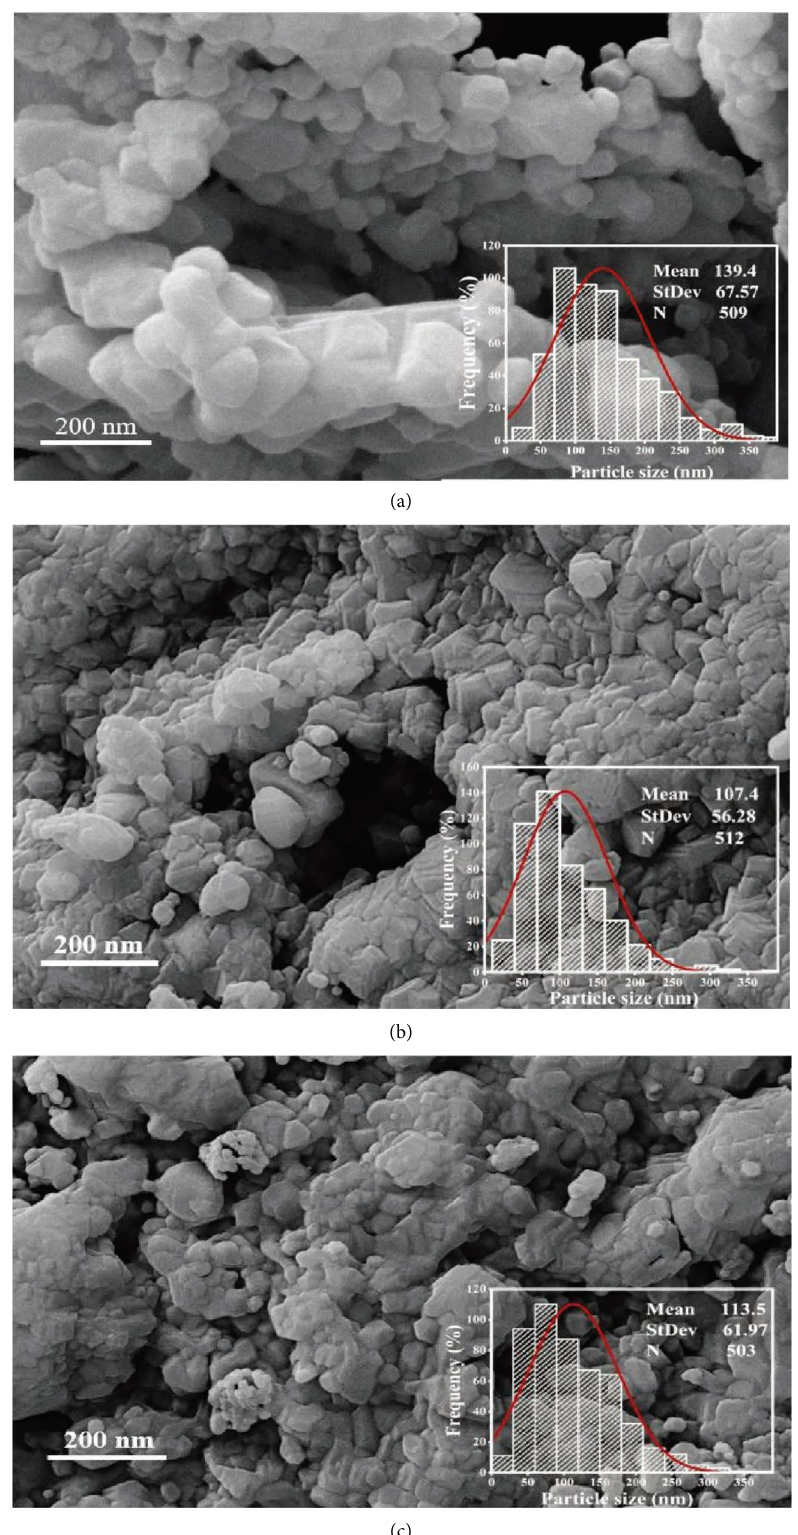
Figure 10: FESEM micrograph of the (a) CoFe the (Inset) corresponding